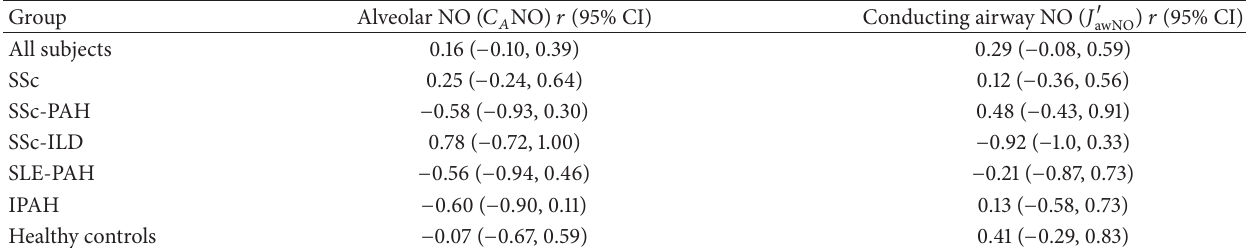
Table 7: Correlation between exhaled NO and